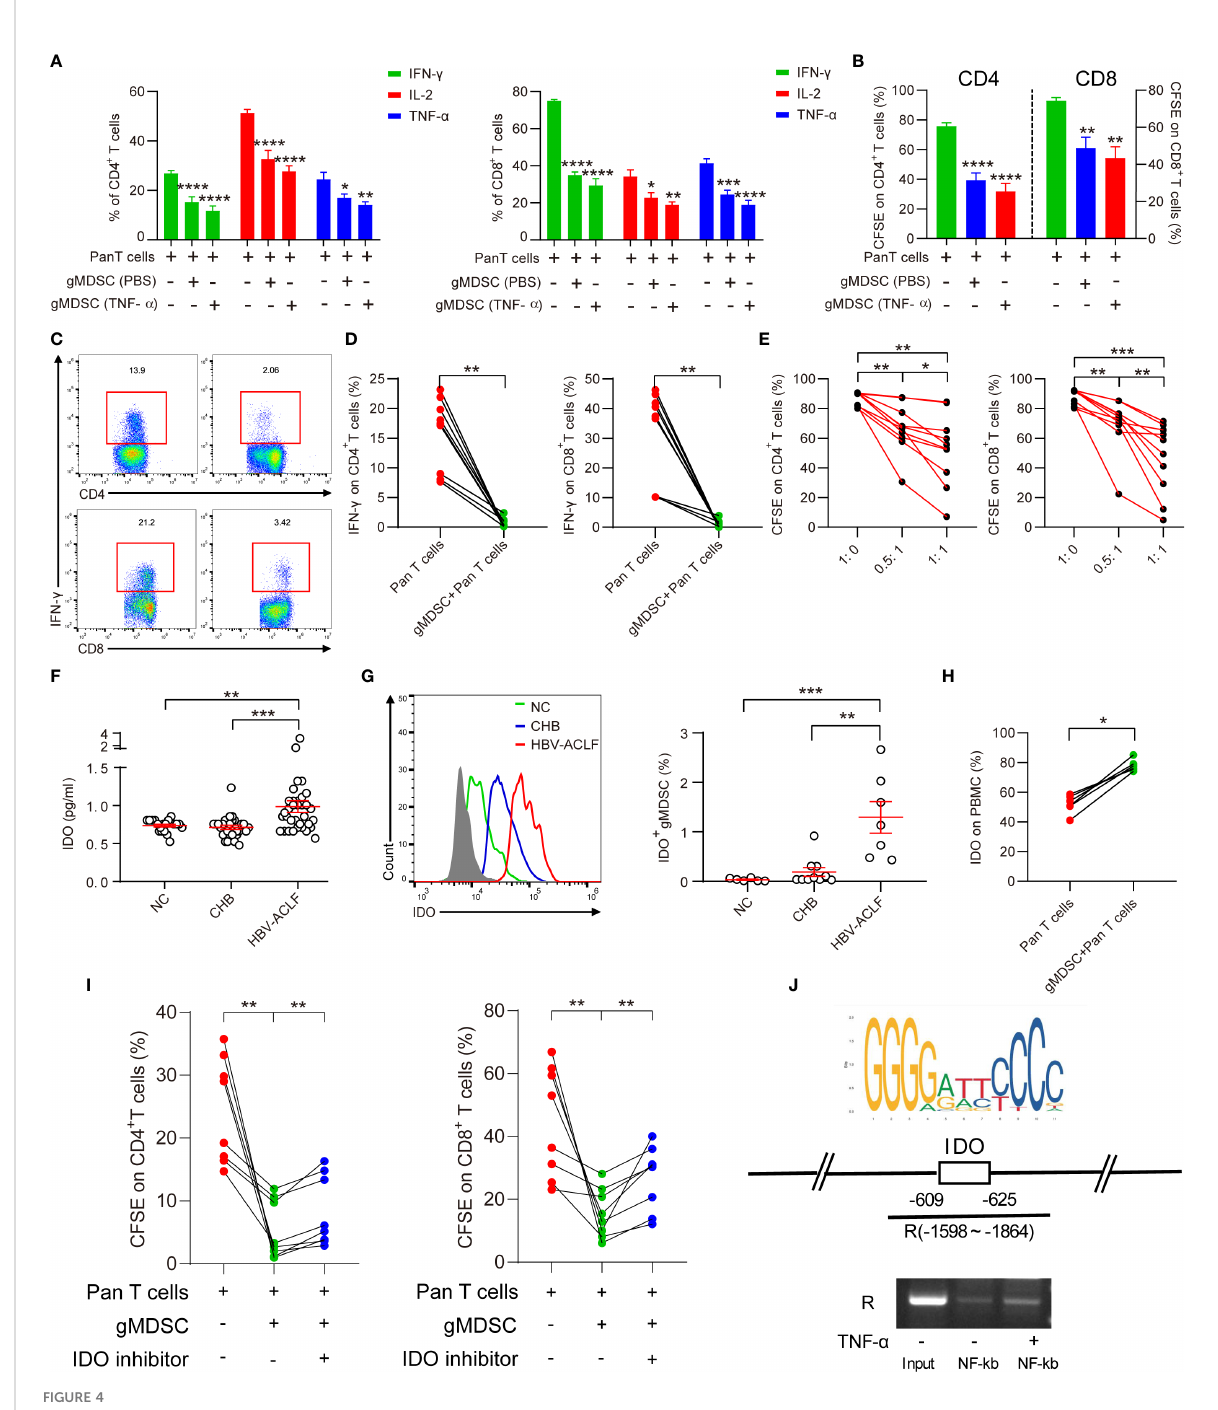
FIGURE 4 gMDSC inhibit cytokine secretion and T cell proliferation via IDO/IL-10 signaling pathway. (A, B) Percentage of cytokines (IFN- g , IL-2, and TNF- a ; A) and proliferation of CD4 + and CD8 + T cells (B) were detected in Pan T cells co-cultured with gMDSC from PBMCs, plus or minus TNF- a stimulation. (C, D) Representative FACS (C) and cumulative dot plot (D) of IFN- g -producing CD4 + and CD8 + T cell frequency after HC Pan T cells were co-cultured with or without gMDSC isolated from HBV-ACLF patients. (E) Cumulative dot plot of CD4 + and CD8 + T cell proliferation after Pan T cells were co-cultured with gMDSC from HBV-ACLF patients at different ratios. (F) Soluble IDO was detected and compared across groups using ELISA. (G) Representative FACS and cumulative dot plot of IDO + gMDSC. (H) Cumulative plot of IDO as a percentage of PBMCs in Pan T cells co-cultured with or without gMDSC from HBV-ACLF patients. (I) Cumulative data for CD4 + and CD8 + T cell proliferation in co- cultured gMDSC with or without exposure to IDO inhibitor. (J) ChIP-qPCR assay con fi rmed that NF-kb, a downstream target of TNF- a , binds to the IDO promoter region. *P <.05, **P <.01, ***P <.001, and ****P